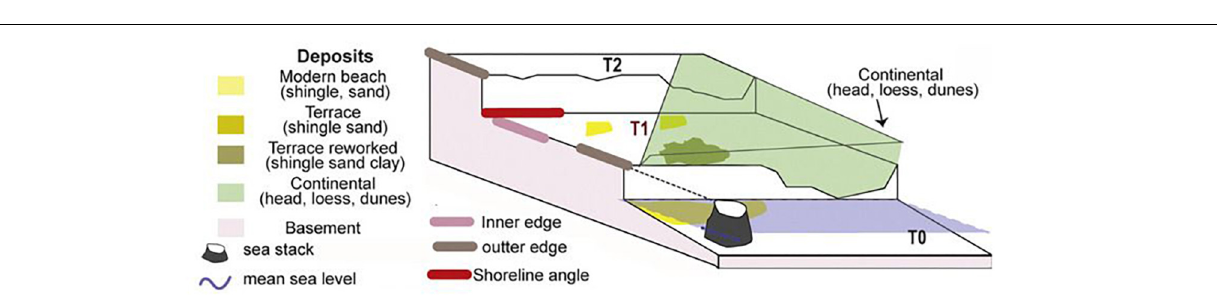
FIGURE 2 | Marine terrace characteristics and sea-stacks (modified from Pedoja et al., 2018). T0 , Modern rocky shore platform; T1 , Marine terrace 1; T2 : Marine terrace